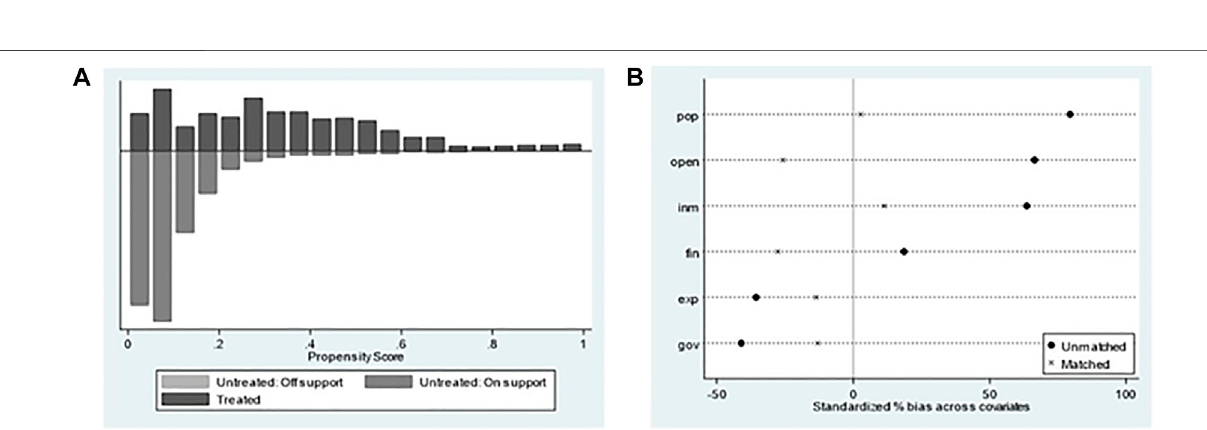
FIGURE 3 | Nuclear density distribution. (A) Prior to matching, the treatment and control group ’ s propensity scores are quite different; (B) After matching, the distribution probability density function values of the two groups are very close.